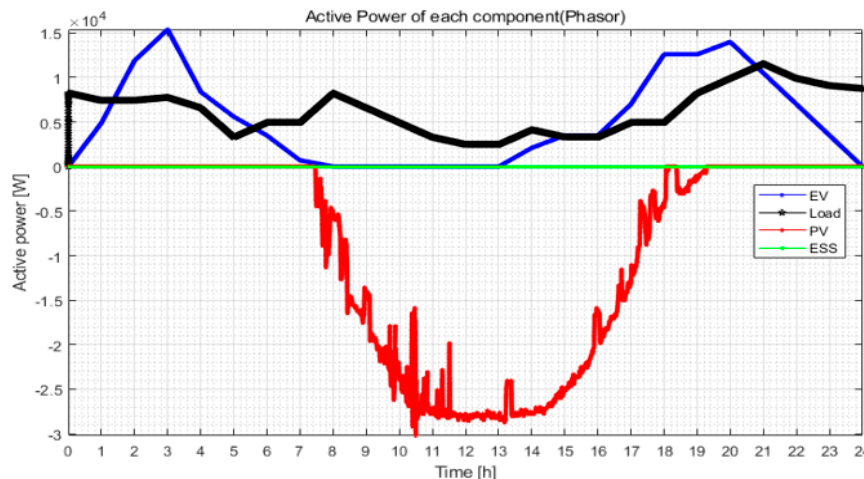
Figure 14. Analysis (power) of active power characteristic without ESS.